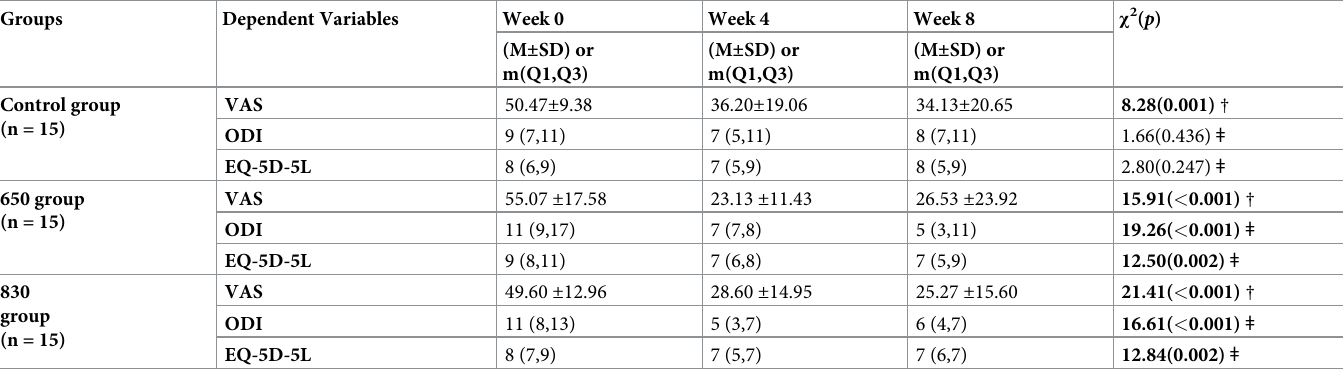
Table 3. Changes in outcome measures after treatment completion in the three